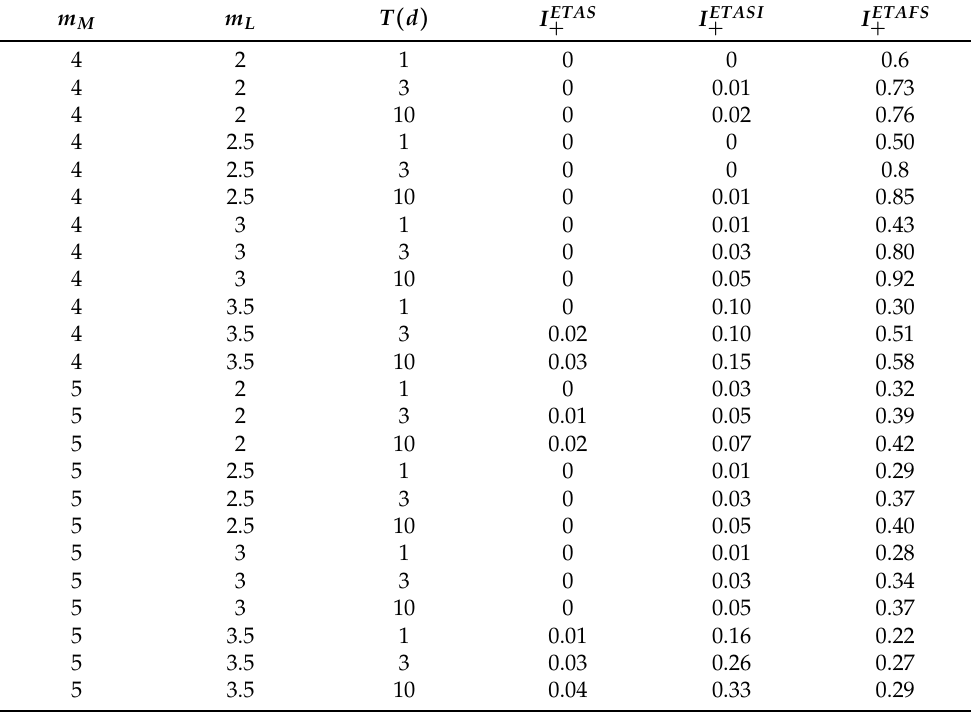
Table 2, where all I ETAFS + Table 2. The positive area below the curve H ( x ) for ETAS and ETASI model for the foreshocks. m M m